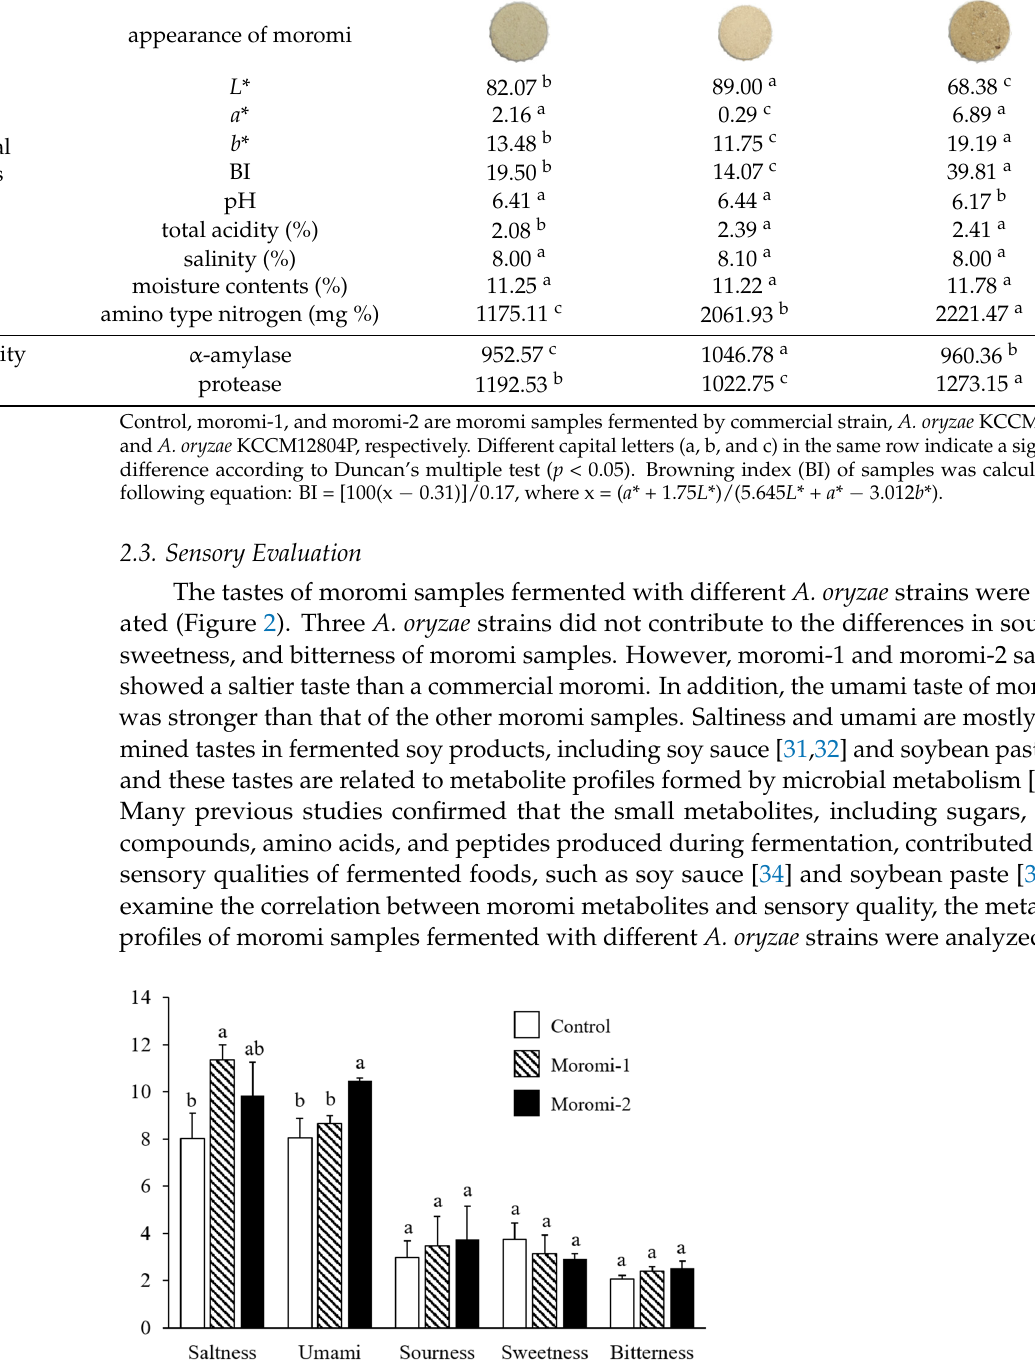
Figure 2. Quantitative descriptive sensory analysis of moromi samples prepared with different A. oryzae strains. Control, moromi-1, and moromi-2 are moromi samples fermented by commercial strain, A. oryzae KCCM13012P, and A. oryzae KCCM12804P, respectively. The intensity of each sensory quality was rated on a 15 cm line scale, labeled “very weak” and “very strong”, with 0.5 cm anchors on the left and right sides. For each taste, the different letters (a and b) in each bar indicate significant difference according to Duncan’s multiple test ( p < 0.05).